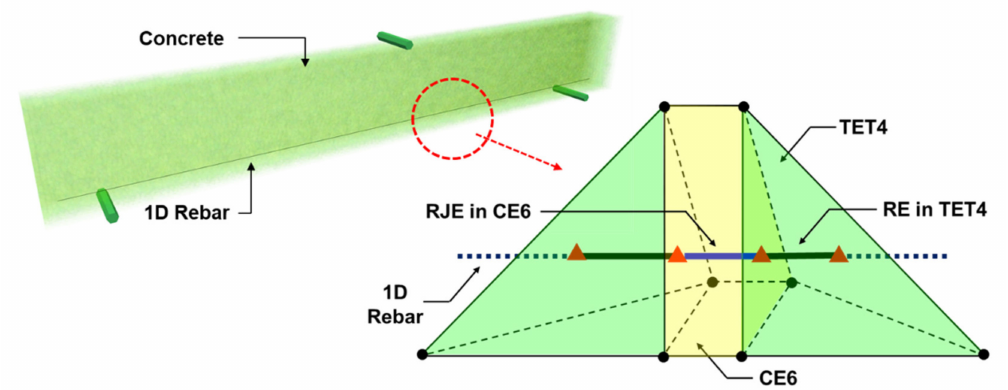
Figure 3. The RC structure as a numerical representation (separation between TET4s is exaggerated for visualization).